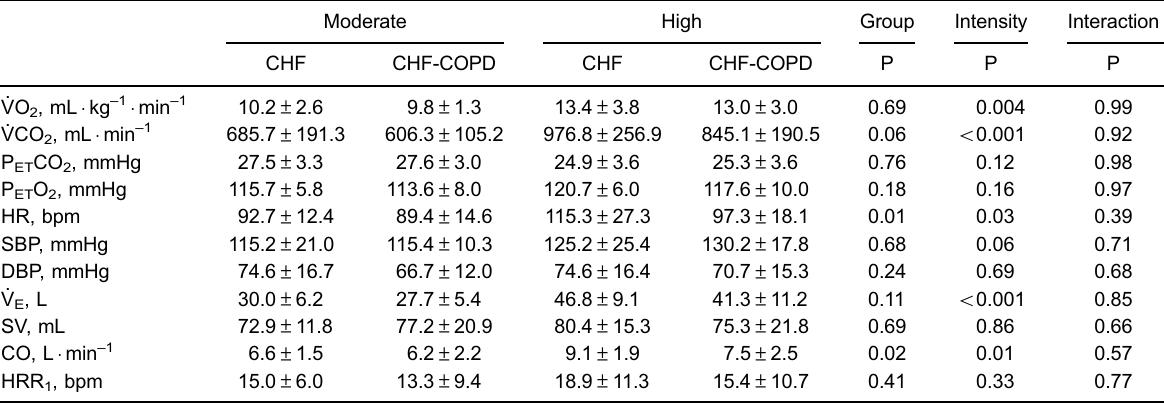
Table 3. Peak responses to moderate and high intensities during constant workload exercise testing in chronic heart failure (CHF) and CHF-chronic obstructive pulmonary disease (COPD) groups. Moderate High